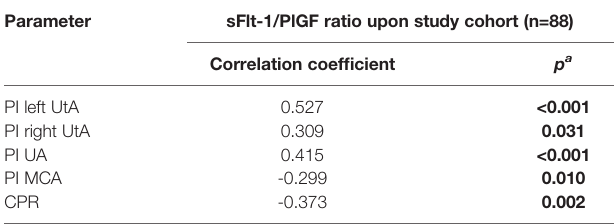
TABLE 2 | Correlation analysis between various ultrasonography parameters and the maternal sFlt-1/PlGF ratio upon study cohort. Parameter